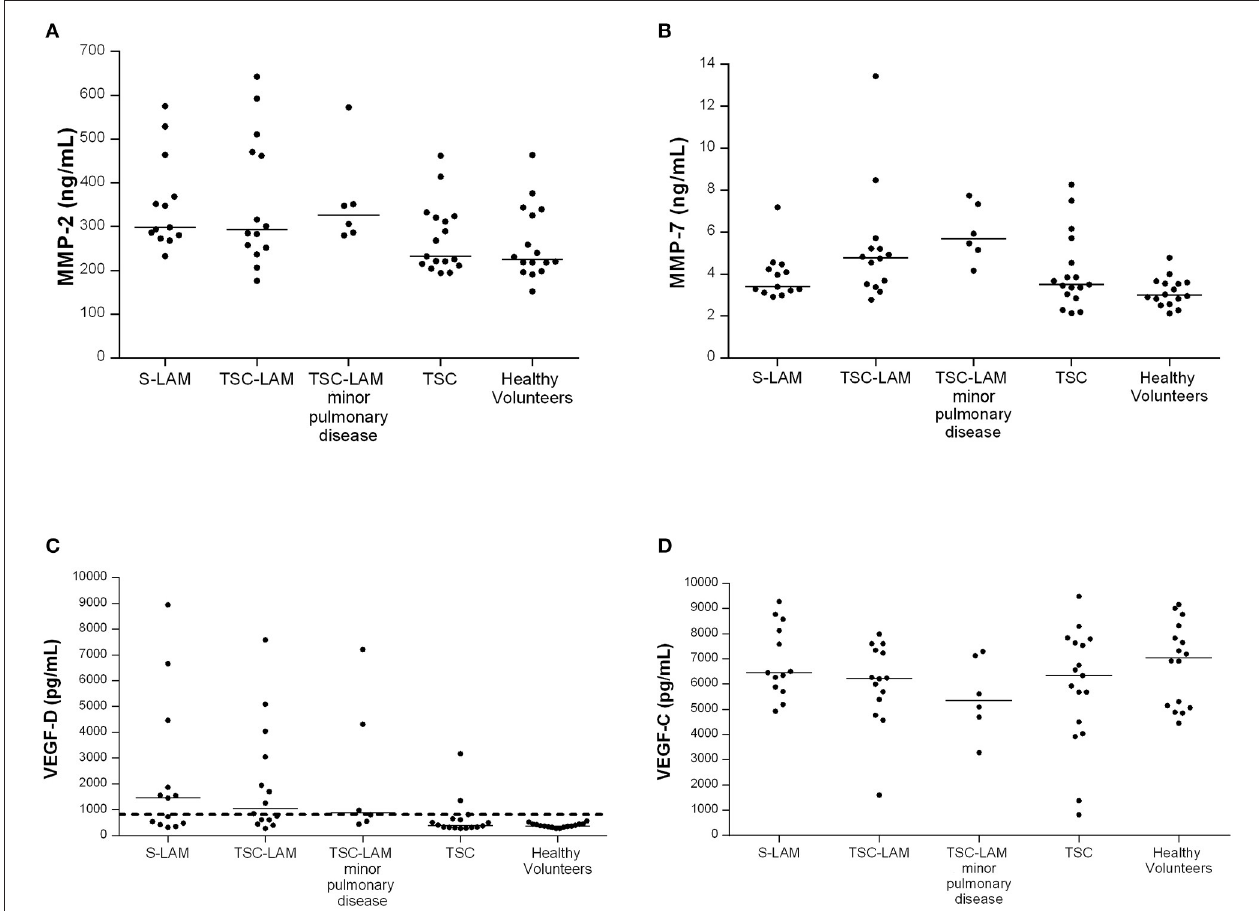
FIGURE 1 | Distribution of MMP-2 (A) p = 0.040, MMP-7 (B) p = 0.001, VEGF-D (C) p < 0.001, VEGF-C (D) p = 0.354, in the study population (p refers to ANOVA); LAM, lymphangioleiomyomatosis; TSC, tuberous sclerosis complex; minor pulmonary disease: patients with < 10 cysts identified at chest CT scan; bar represents the median value, dashed line represents VEGF-D value of 800